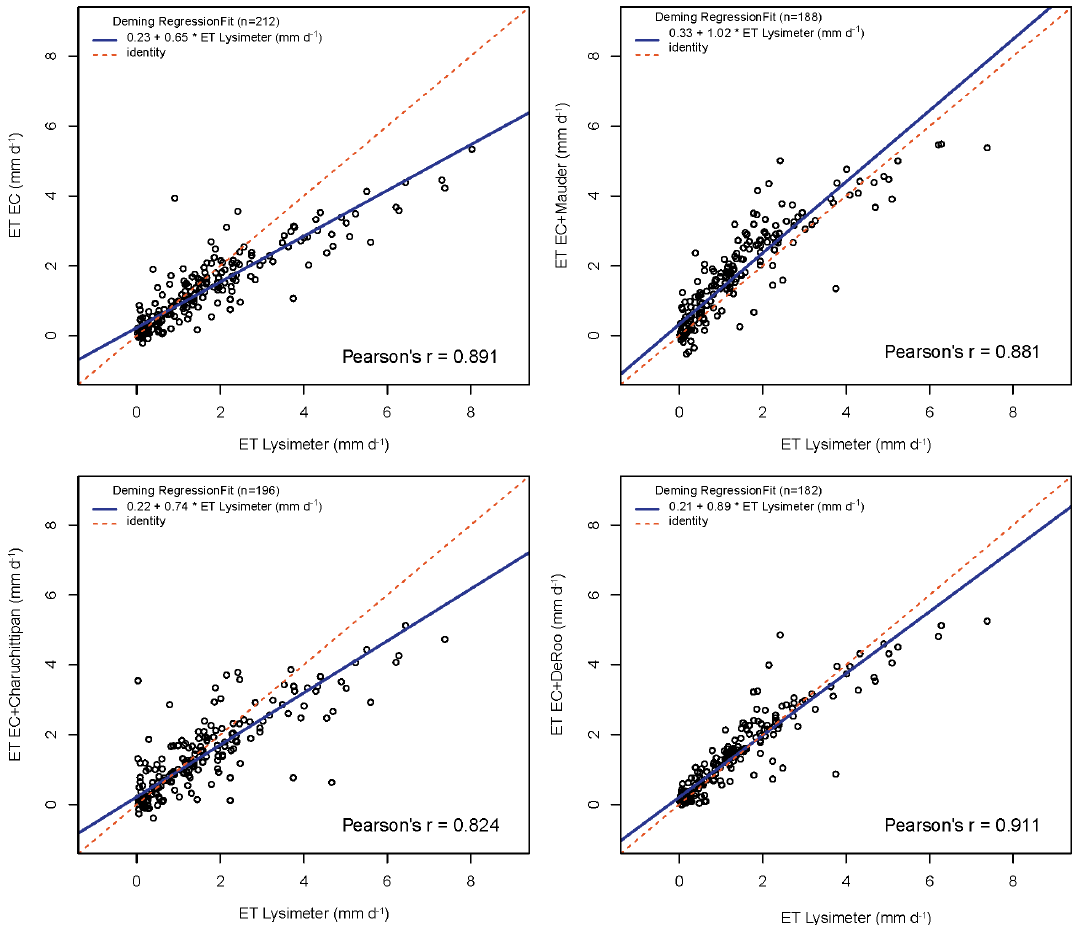
Figure 11. Comparison of daily evapotranspiration (ET) estimates based on eddy-covariance measurements after different variants of energy balance closure correction with daily ET estimates based on lysimeter measurements for the DE-Gwg dataset. Table 2. Bias or mean error of the different daily ET estimates (in mm) for the different SEB closure correction methods. Bias (mm) No